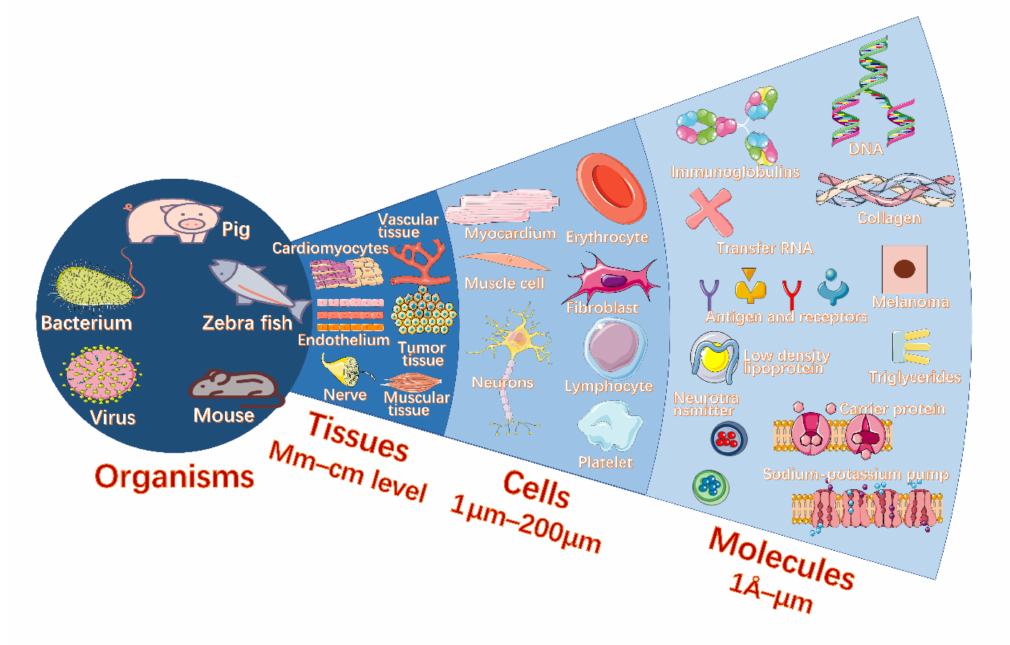
Figure 1. The overview of biolasers in different life levels, including organisms, tissues, cells, and